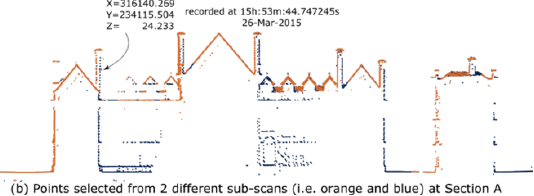
Figure 1. Sample discrete point LiDAR